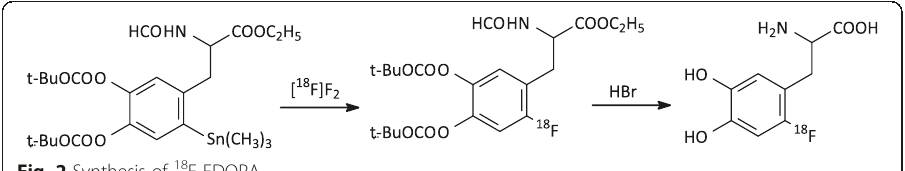
Fig. 2 Synthesis of 18